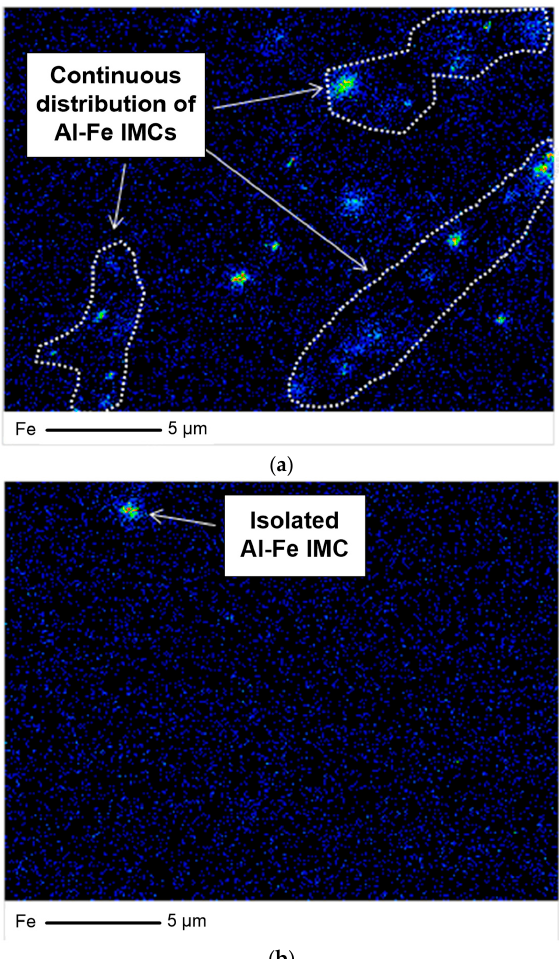
Figure 8. Analysis of Al-Fe IMP distribution using field emission electron probe microanalysis (FE-EPMA) mapping: ( a ) A1070 and ( b ) U1070.